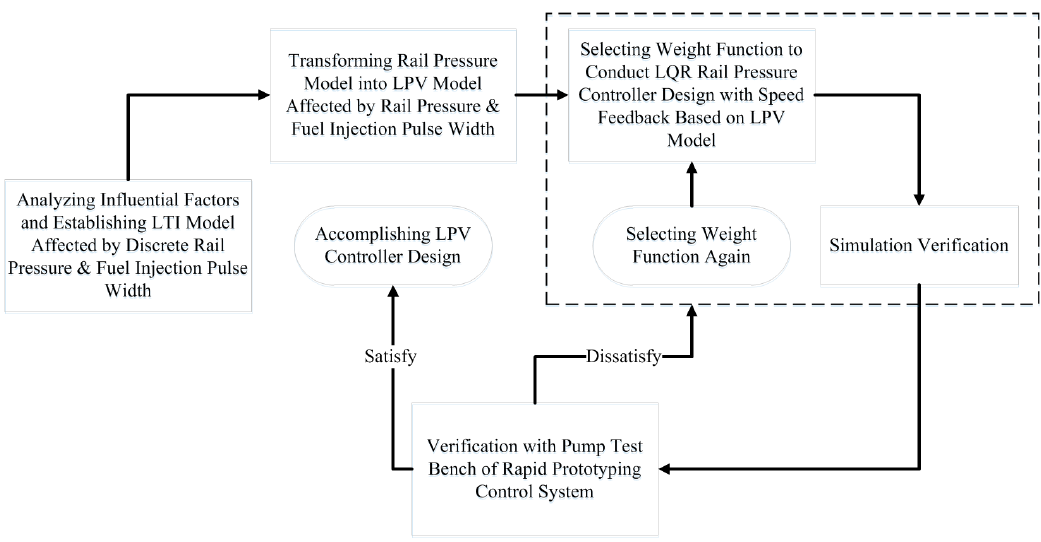
Figure 5. Design flow of the LQR scheduling control algorithm based on the LPV model.